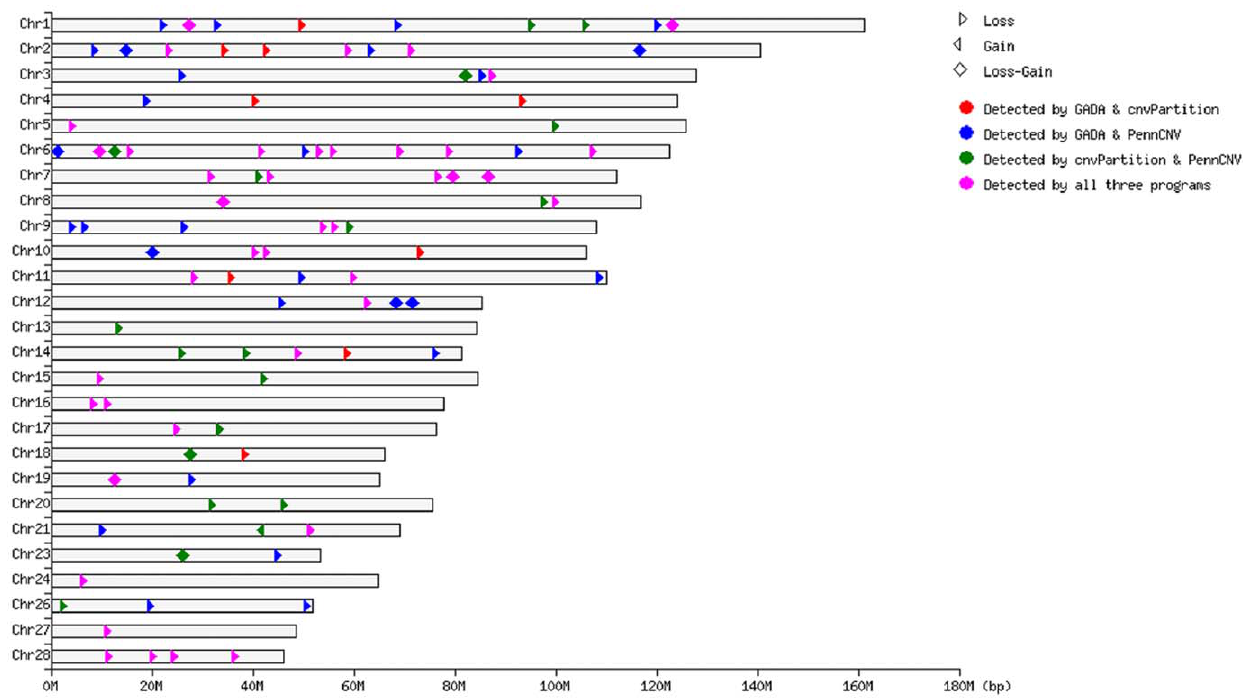
Figure 2. The distribution and status of detected CNVRs across the bovine genome (based on the Btau_4.0 assembly).